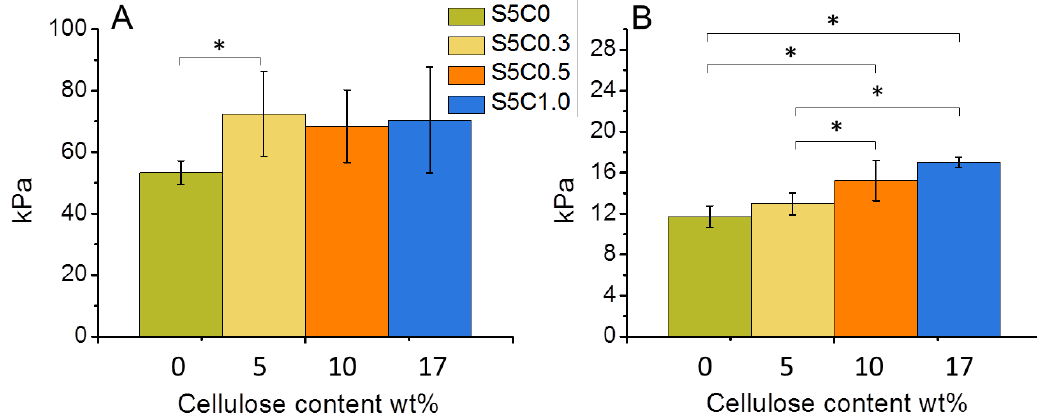
Figure 4. Change of compressive modulus ( A ) and compressive strength at 30% strain ( B ) of wet SF/cellulose hydrogels depending on the amount of cellulose. Significant difference ( p < 0.05) is indicated by an asterisk symbol (*).